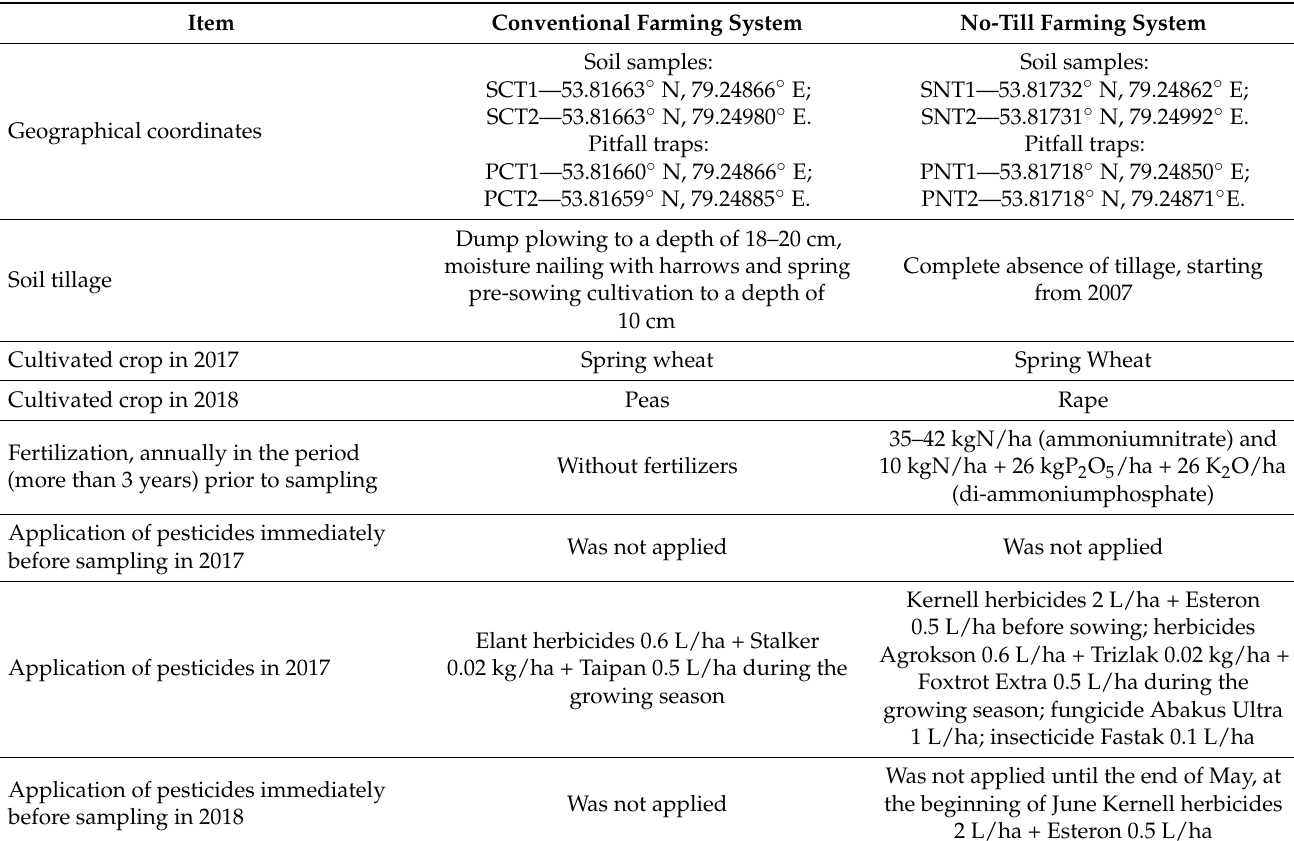
Table 1. Agrotechnical and agrochemical treatments for two farming